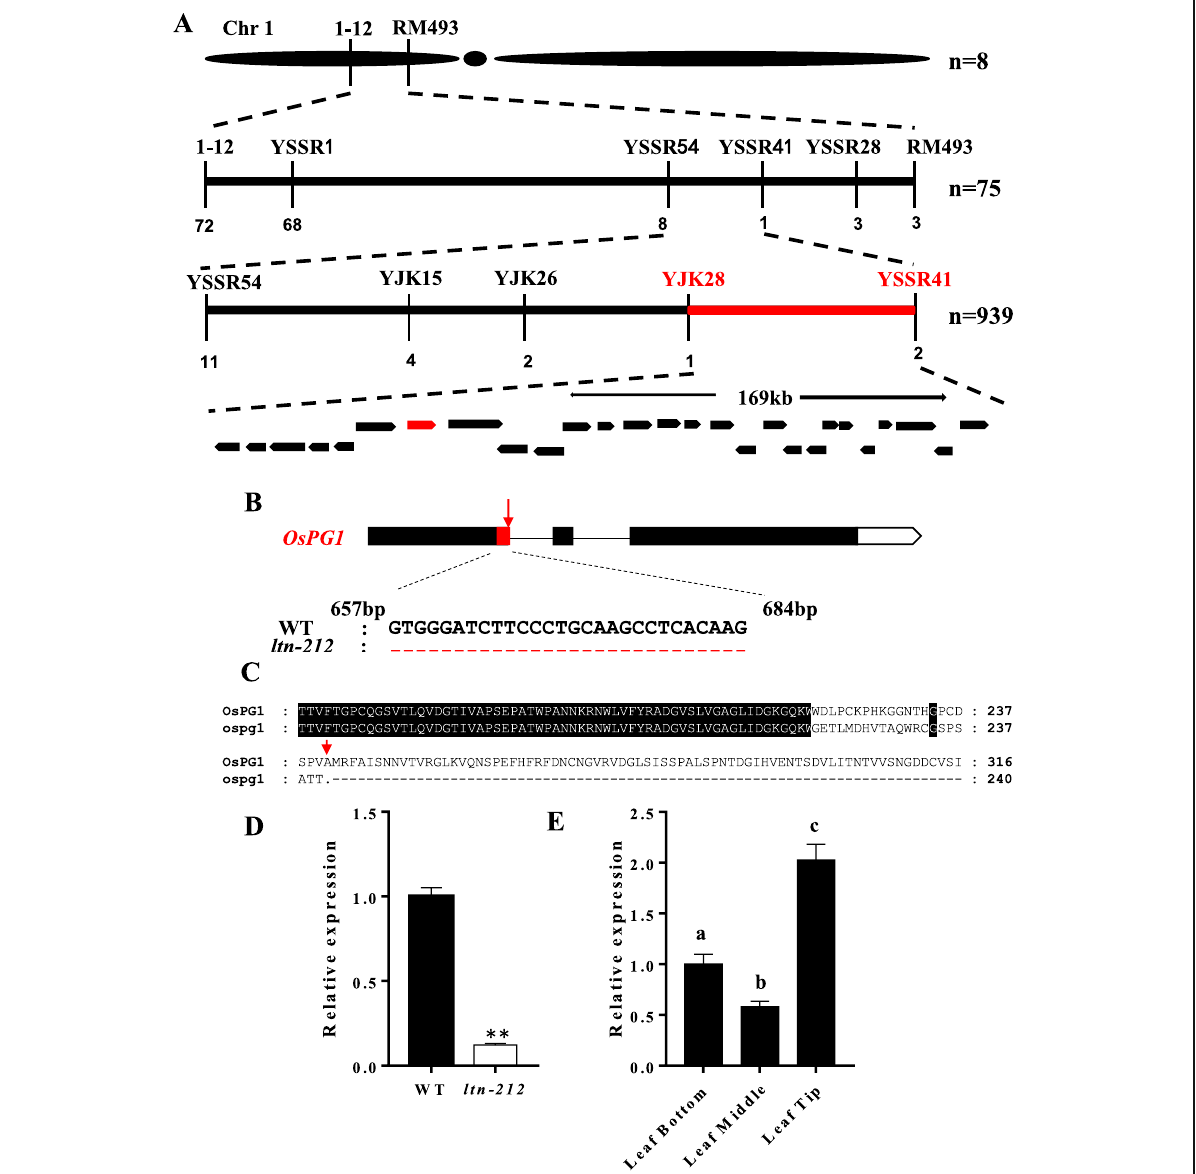
Fig. 4 Cloning analysis of the OsPG1 . a Fine mapping of OsPG1 . b Gene structure and the mutation of genome and cDNA in OsPG1 . The red arrow indicates the mutant site and the red dotted line indicates the incorrected splicing sequences. c Protein sequence alignment of OsPG1 and ospg1. d Expression analysis of OsPG1 in WT and ltn-212 leaves (n=3). e Expression analysis of OsPG1 in WT leaf bottom, middle and tip (n=3). Data are means ± SD. ** indicates significance at P ≤ 0.01 and * indicates significance at P ≤ 0.05. a, b, c indicates significance at P ≤ 0.01 (Student ’ s t